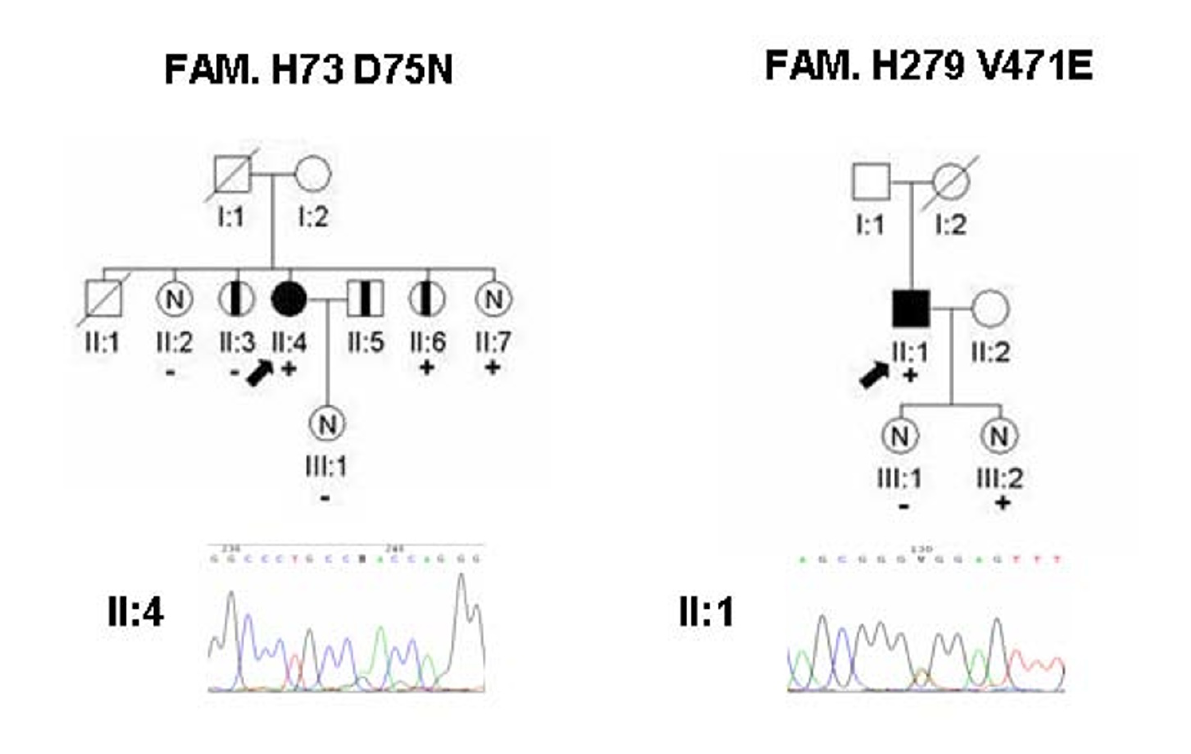
Figure 3 Pedigrees with the electropherogram of the new missense mutations . Squares are males and circles are females. Filled in black are cas- es with HCM. Symbols with a black vertical bar represent relatives that were considered possibly affected. N means normal phenotype, empty symbols are non-evaluated relatives. The arrows indicate the index patients. Diagonal lines indicate deceased individual. + indicate carriers of the mutation and - indicates the